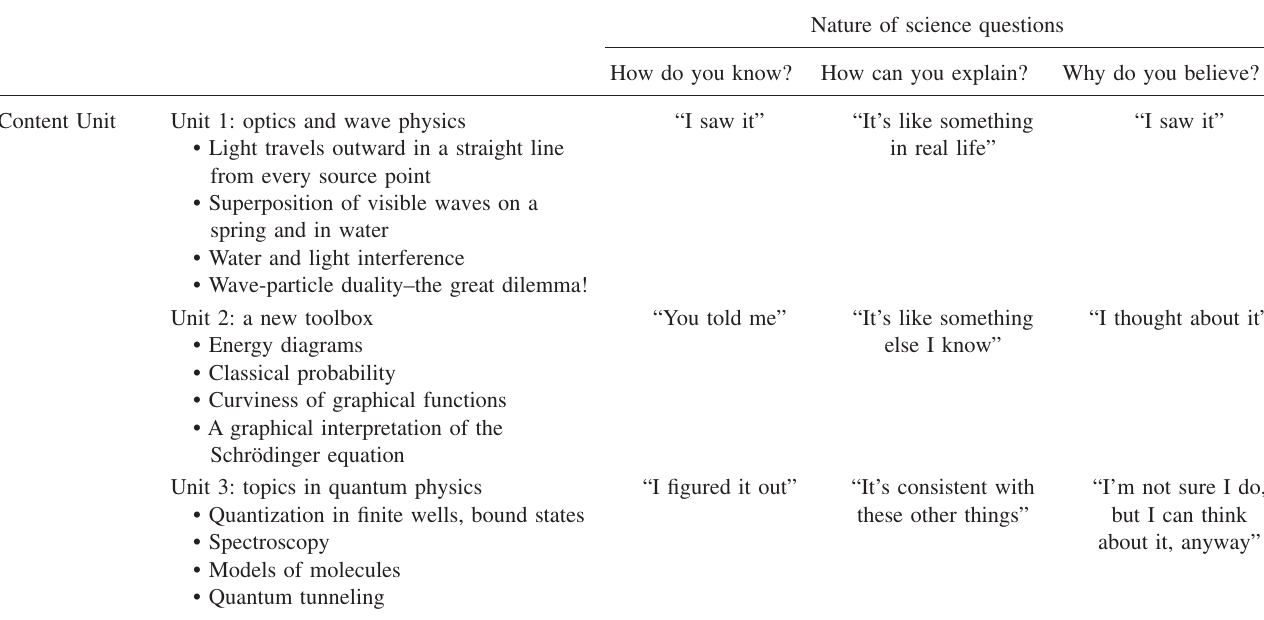
TABLE I. Course outline. Each unit has specific goals concerning content knowledge and the nature of